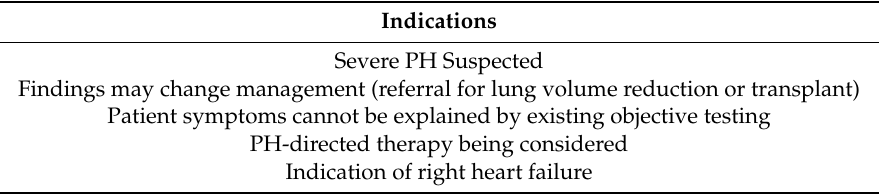
Table 2. Indications for right heart catheterization in patients with group III PH.